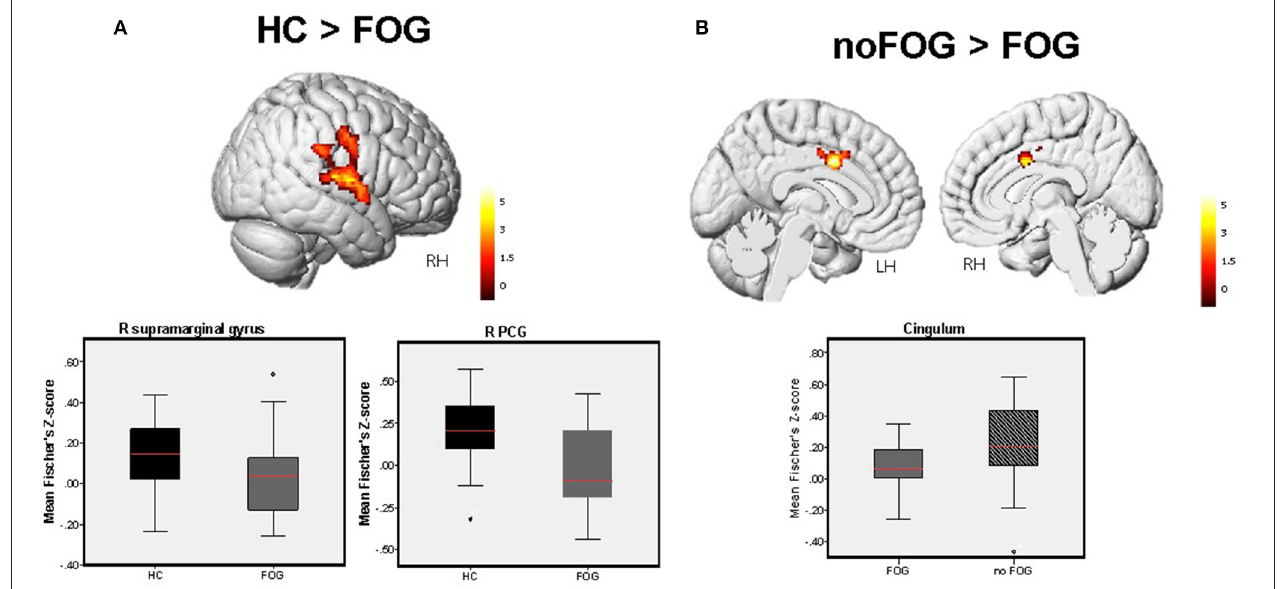
FIGURE 1 | Between-group difference in FC levels within the brainstem network detected by one-way ANOVA (1x3) adjusted for age. (A) Significant FC decrease in the R PCG extending to the right supramarginal gyrus, and R STG was observed in PD-FOG vs. HCs. (B) Significant FC reduction in the cingulum was observed in PD-FOG compared to PD-noFOG. Bar charts demonstrate the mean and standard error of FC levels within these significant clusters across the three study groups. Results are reported at p < 0.001, FWEc in all